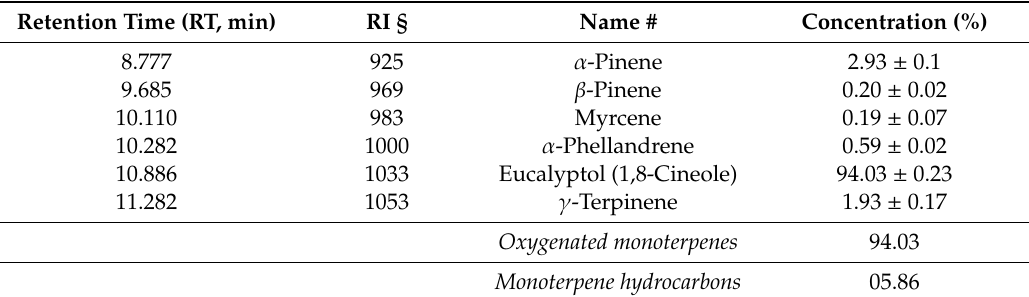
Table 1. Chemical profile of EO from Eucalyptus globulus analyzed with GC-MS.